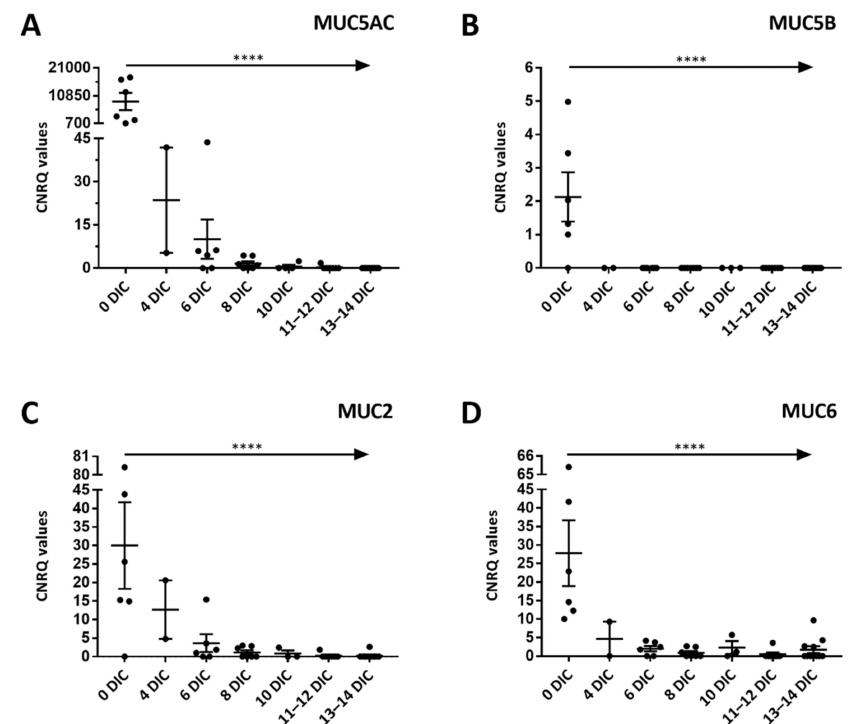
Figure 2. mRNA expression of gel-forming mucins during a two-week culture period. Transcript levels of cells enzymatically removed from conjunctival tissue and cells from conjunctival explant cultures are normalized and set against the lowest expression levels found in all the samples for each gene separately to obtain the Calibrated Normalized Relative Quantity (CNRQ) values. Quantifica- tions were performed for mucin (MUC)5AC ( A ), MUC5B ( B ), MUC2 ( C ), and MUC6 ( D ) on 0–14 days in culture (DIC). Each dot represents a CNRQ value of a different donor at each specific time point. Data are depicted as the mean ± SEM and fitted in a mixed effect model was p -value < 0.0001 (****) for each type of